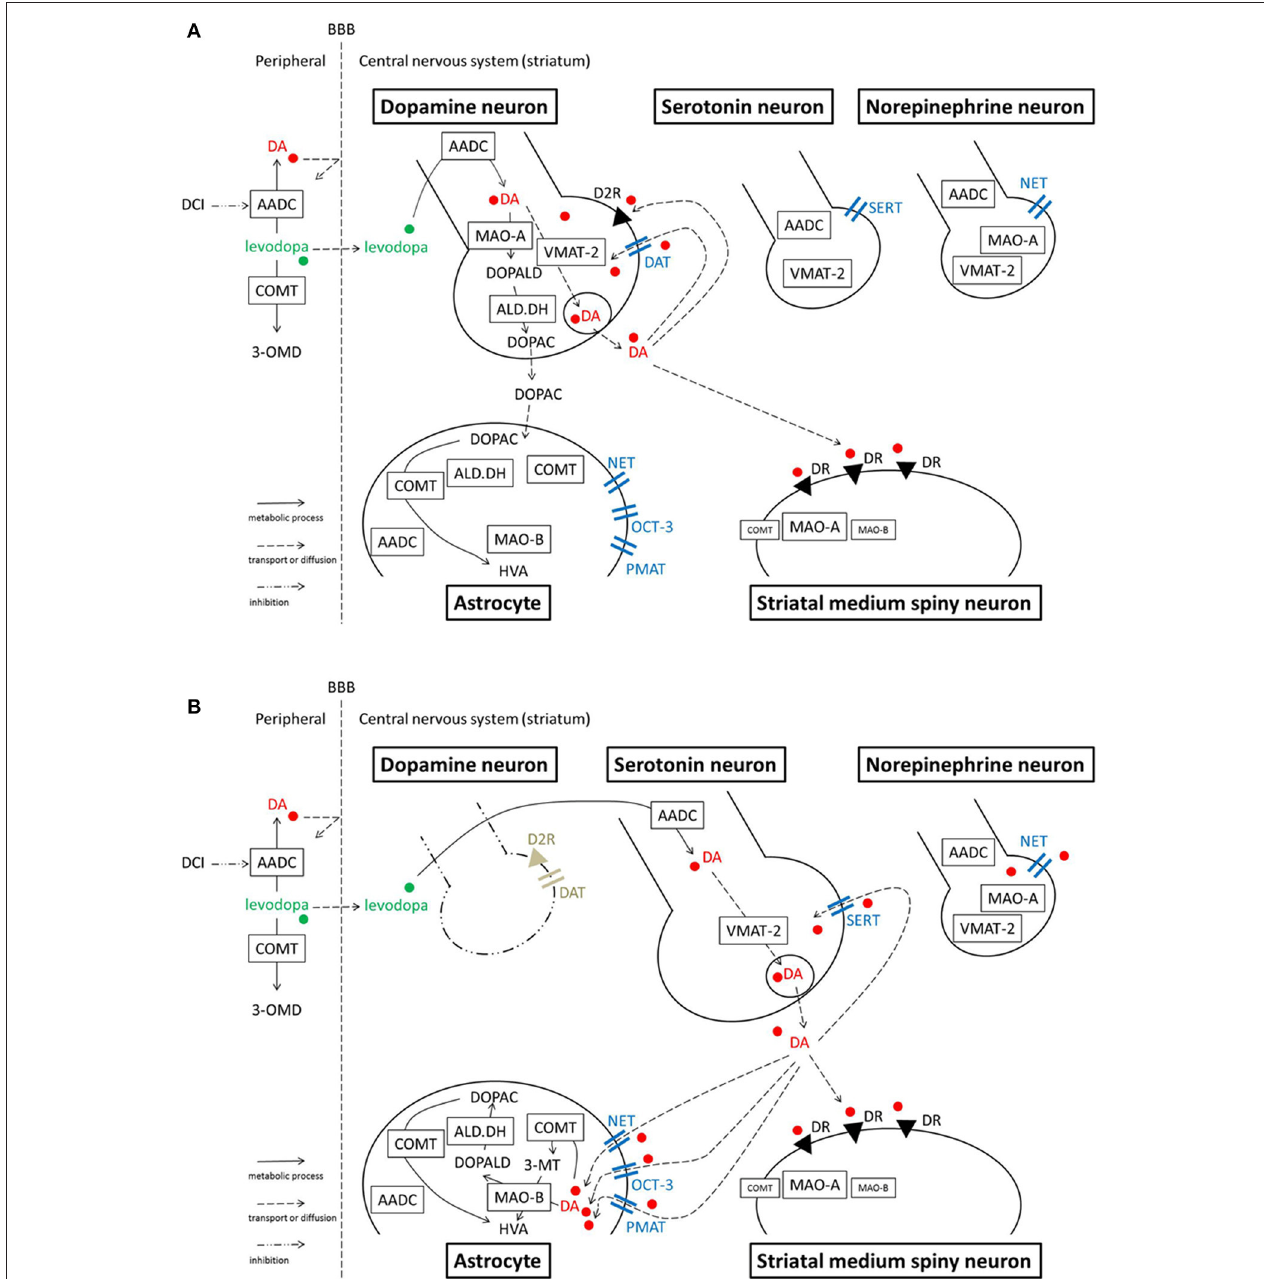
FIGURE 2 | Model illustrating the processes of levodopa-dopamine metabolism and uptake. (A) Normal striatum (B) Dopamine-denervated striatum. Note that MAO-A localization is unclear. A study suggests MAO-A is mainly expressed in medium spiny neurons, rather than in axon terminals in the striatum. Serotonergic neurons express MAO-B in their cell bodies, however, it is still unclear whether the neurons express MAO in axon terminals. OCT-3 also exists in neurons, however the specific subtype is unknown. PMAT is illustrated at the astrocyte membrane according to one recent study (see text), although its localization is not certain yet. 3-MT, 3-methoxytyramine; 3-OMD, 3-O-methyldopa; AADC, aromatic amino acid decarboxylase; ALD.DH, aldehyde dehydrogenase; COMT, catechol-O-methyltransferase; D2R, dopamine D2 receptor; DA, dopamine; DAT, dopamine transporter; DCI, dopa-decarboxylase inhibitor; DOPAC, dihydroxyphenylacetic acid; DOPALD, dihydroxyphenylacetaldehyde; DR, dopamine receptor; HVA, homovanillic acid; MAO, monoamine oxidase; NET, norepinephrine transporter, noradrenaline transporter; OCT, organic cation transporter; PMAT, plasma membrane monoamine transporter; SERT, serotonin transporter; VMAT-2, vesicular monoamine